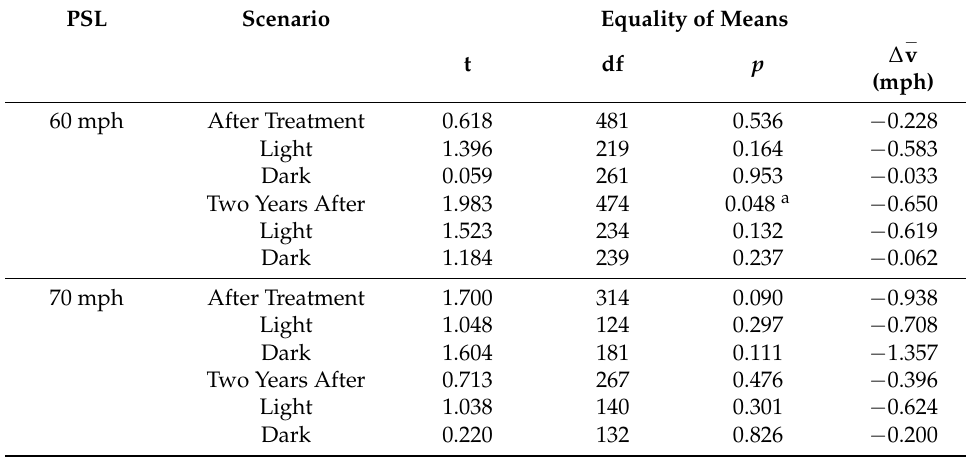
Table 3. Change in mean excess speed by posted speed